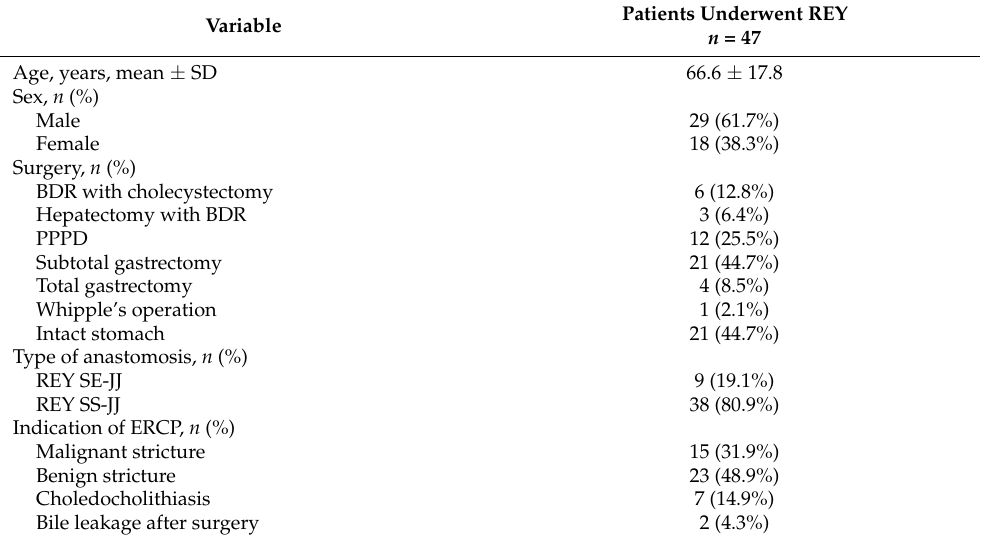
Table 1. Baseline characteristics of the patients.